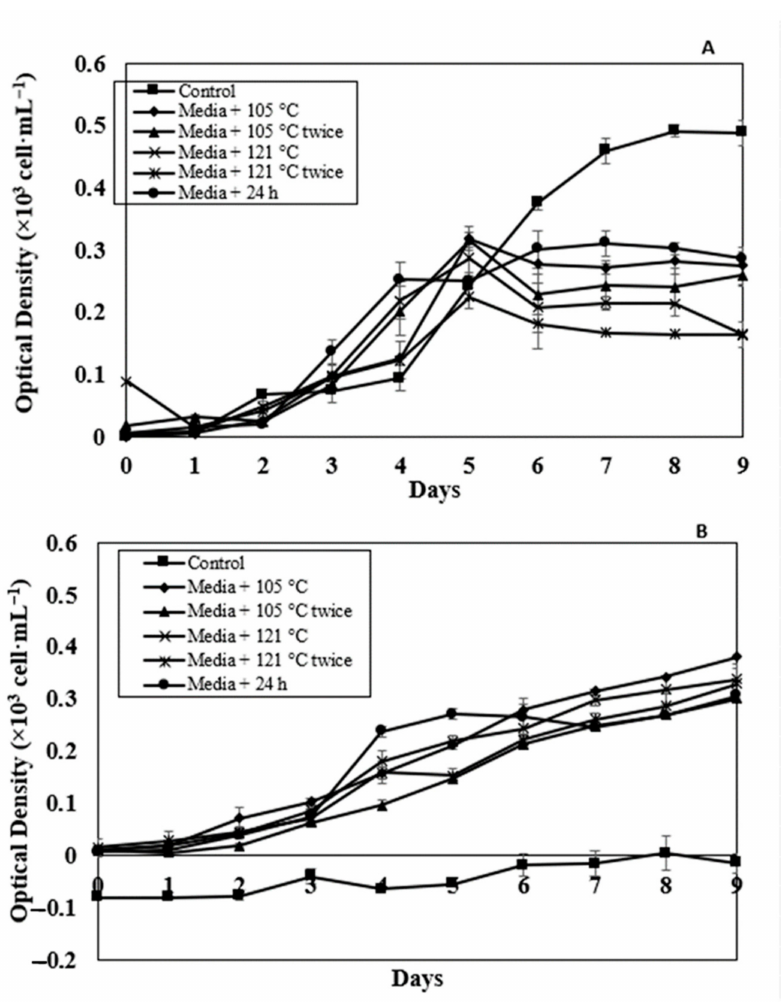
Figure 7. Optical density at 680 nm of N.oceanica in control, media + 105 ◦ C, media + 105 ◦ C twice, media + 121 ◦ C, media + 121 ◦ C twice and media + 24 h (media + 105 ◦ C—autoclave 105 ◦ C; media + 105 ◦ C twice—autoclave 105 ◦ C 2 × after natural extraction 24 h; media + 121 ◦ C—autoclave 121 ◦ C after natural extraction 24 h; media + 121 ◦ C × 2—autoclave 121 ◦ C twice after natural extraction 24 h; media + 24 H—natural extraction for 24 h). ( A ) RM SE and ( B ) AH SE. Error bars represent standard deviation ( n =